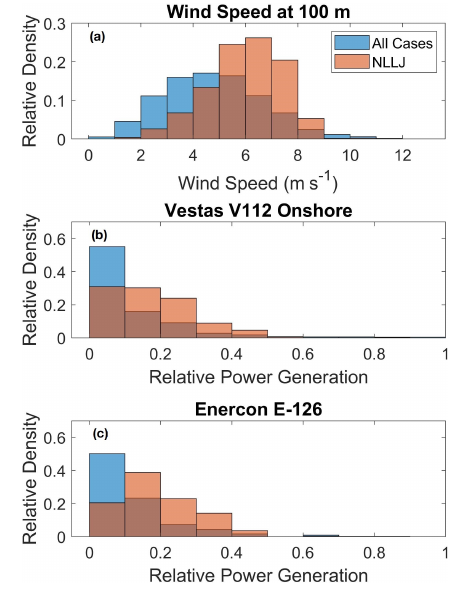
Figure 15. Wind power production associated with NLLJs. Shown are the frequency of (a) the wind speed at 100ma.g.l. and the rel- ative power production from (b) E-126 and (c) V112 for all cases (blue) and NLLJ conditions (red). The relative power generation was calculated relative to the rated power of the turbine